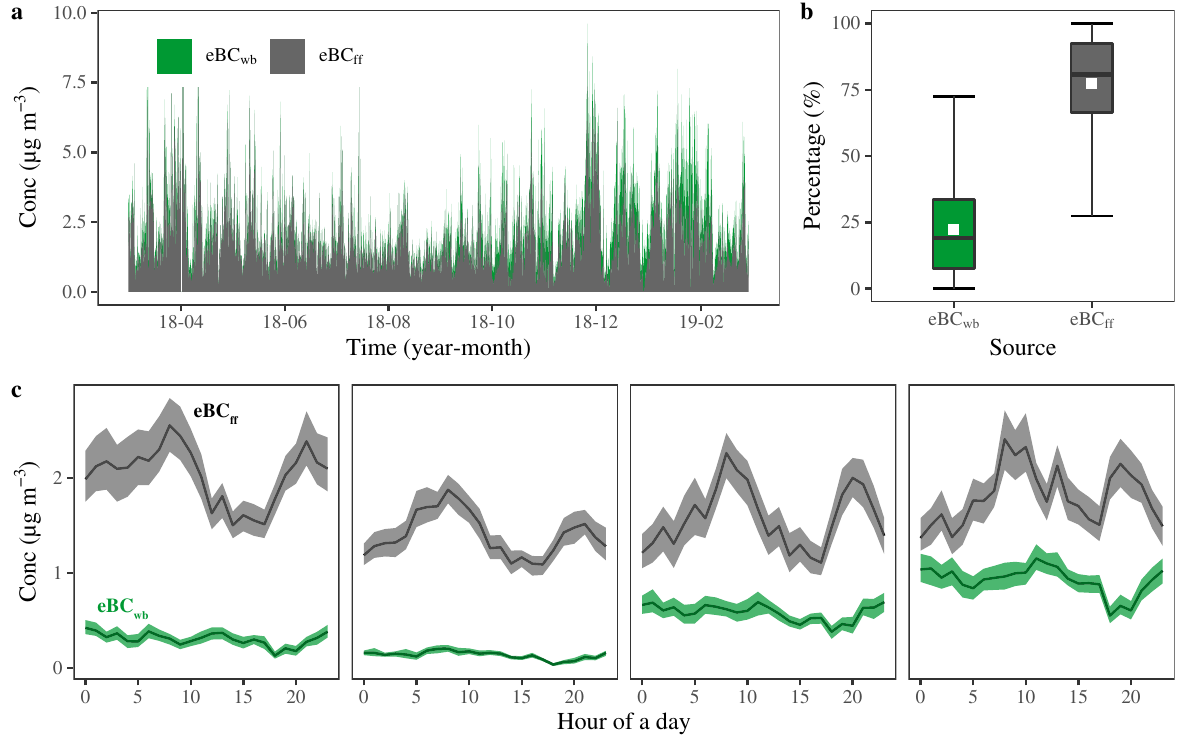
Fig. 5 BC source apportionment results using the dynamic absorption Ångström exponents. a Hourly variations of black carbon sources during the observational period. b Boxplot of their relative contributions to BC mass concentration. c Diurnal variations of BC sources in different seasons. The fi lled areas in panel c represent the 95% con fi dence intervals of mean